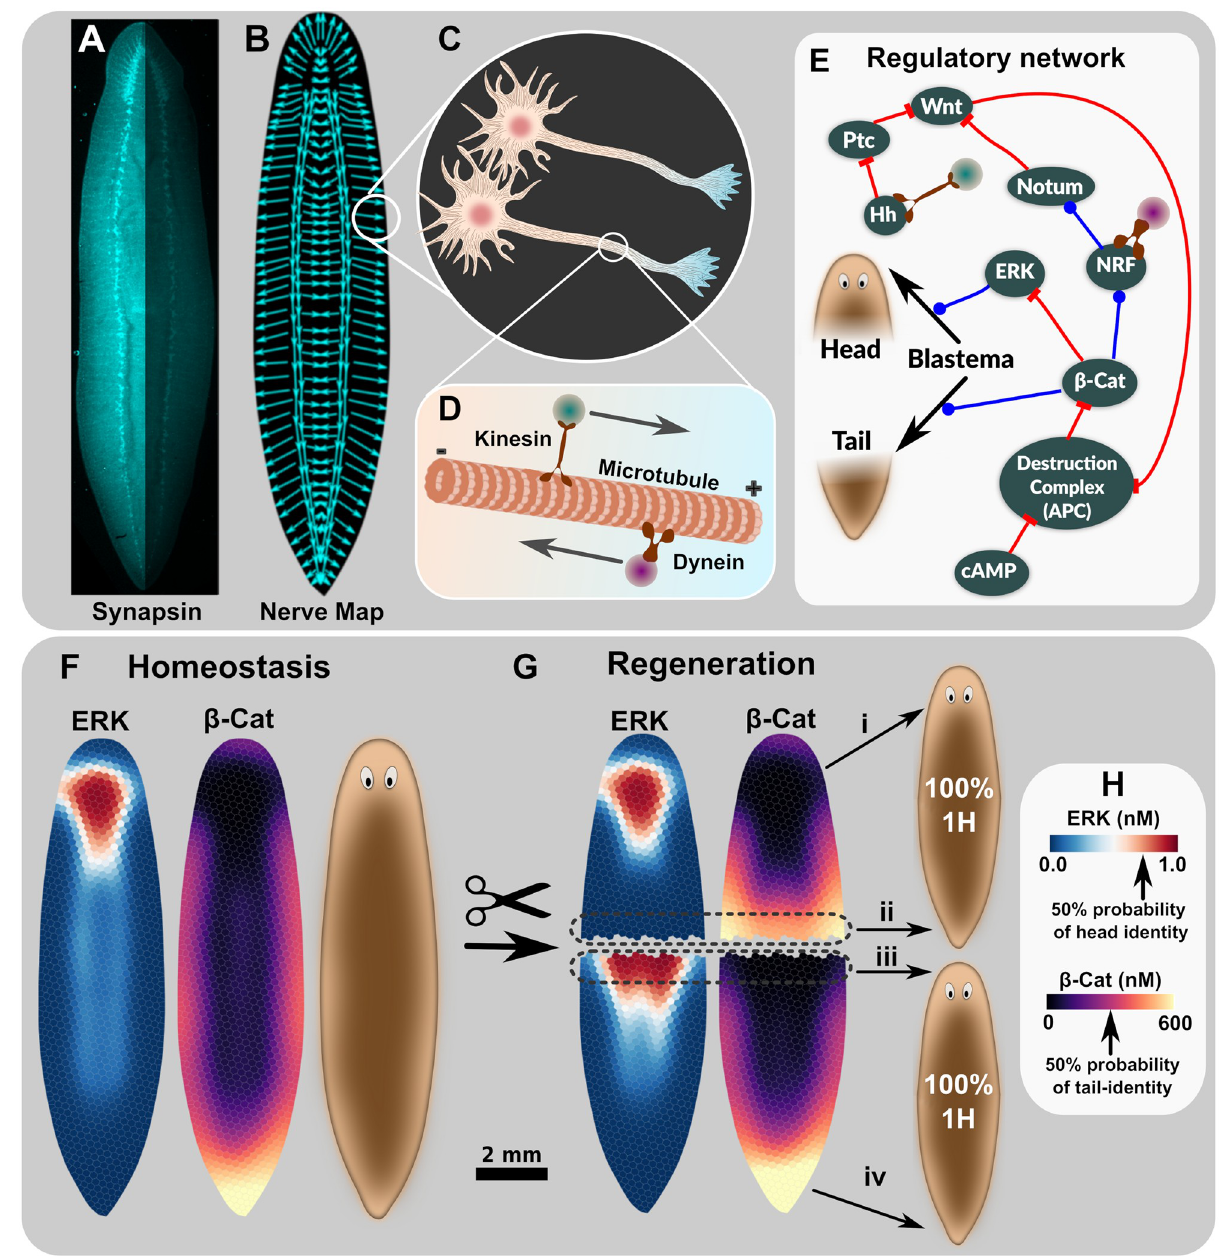
Fig 1. A conceptual summary of our model of anterior-posterior axis control in planaria regeneration. We hypothesize morphogens to be transported on a vector field coincident with neuronal axons (A), with hypothesized transport polarity as shown in (B). We further hypothesize that vector transport of morphogens occurs on aligned microtubule arrays in nerve axons (C, D). A regulatory network (E) integrates molecular-genetic interactions with vector transport in nerves to produce stable, self-assembling morphogen gradients consistent with planarian body-plan in homeostasis (F), and capable of responding to cutting event perturbations to establish new gradients (G). Head and tail regeneration are assumed to be related to concentrations of ERK and β -Cat, respectively (F, G, H). The percentage of regenerated heteromorphoses in a population was estimated from steady- state ERK and β -Cat gradients after cutting (G), where average morphogen concentration at wound edges (G ii , and iii ) were used to define the probability of the blastema developing into a head or tail (G, H) using a Markov Chain Model for Regeneration (see text and Fig 3 for details). Head (G, transition ‘ i ’) and tail (G, transition ‘ iv ’) regions existing on a fragment prior to cutting were assumed to be terminally differentiated, and to therefore remain as head or tail in the regenerated fragment. In the regulatory network of E, blue lines with circular endpoints represent activating interaction, whereas red lines with flat-line ends represent an inhibitory relationship. Kinesin symbol on Hedgehog node, and dynein symbol on NRF, signify proposed transport of the respective factors. Hh—Hedgehog, Ptc—Patched, Wnt—Wingless/integrated (Wnt1 and Wnt11 combined), β -Cat— β - Catenin, ERK—extracellular-signal regulated kinase, cAMP—cyclic adenosine monophophate, NRF—Notum Regulating Factor.